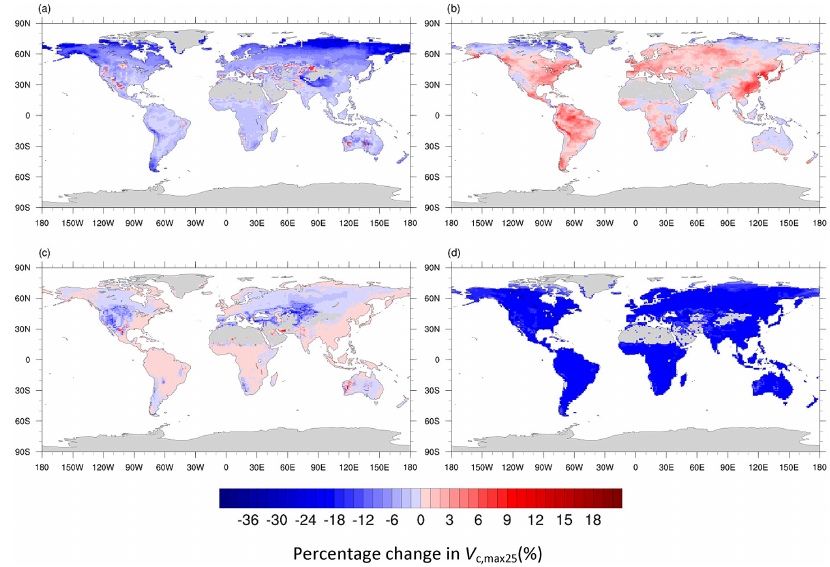
Figure 5. Sensitivity of V c,max25 (µmolCO 2 m − 2 s − 1 ) to projected future changes in environmental variables including temperature (a) , radiation (b) , humidity (c) and CO 2 (d) at the global scale for TRF1. The sensitivity analysis is conducted by changing the value of an individual environmental variable from its 10-year monthly averages in the past (1995–2004) to those in the future (2090–2099) for each individual grid cell across the globe. Positive values indicate that the increase in a specific environmental variable leads to larger values of V c,max25 , while negative values indicate that the increase in a specific environmental variable leads to smaller values of V c,max25